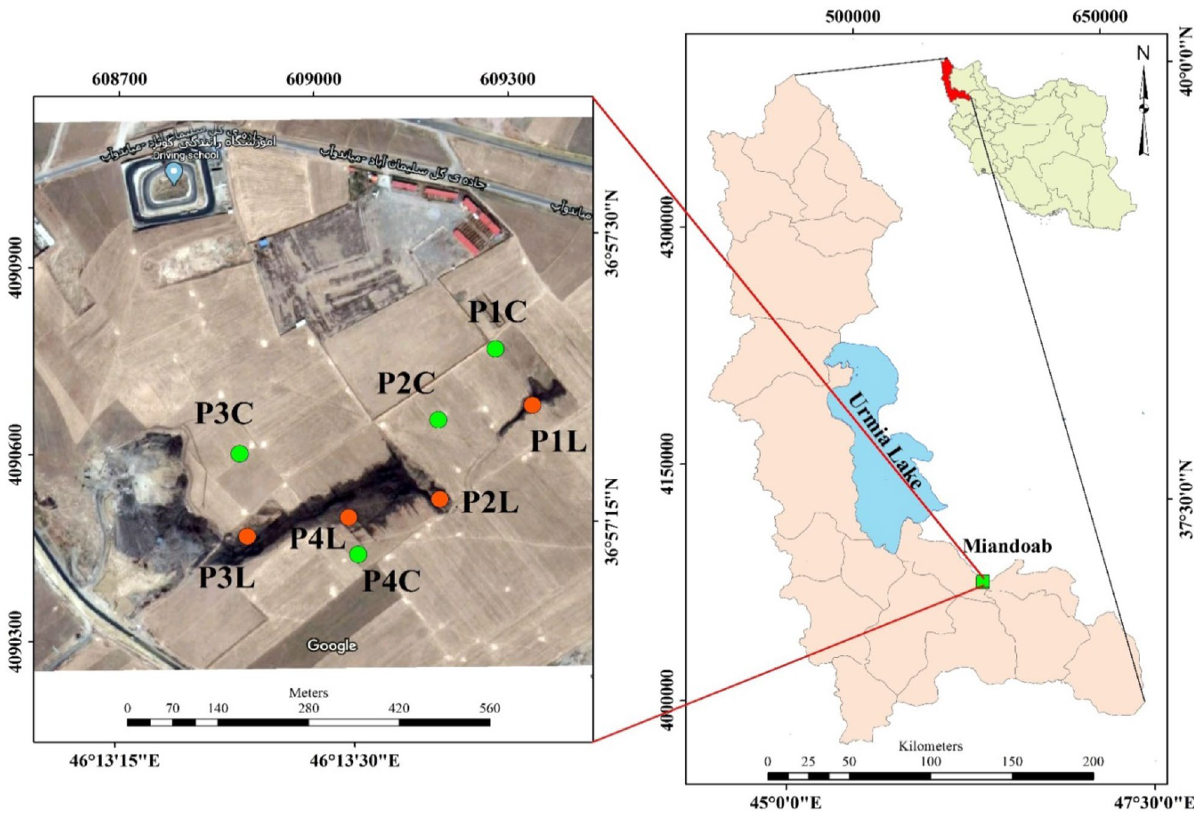
Figure 1. Location of the study area ( (P1L, …, the soil under influence of leachate; P1C,… the adjacent control soils) (https:// www. qgis. org/ and https:// www. google. com/